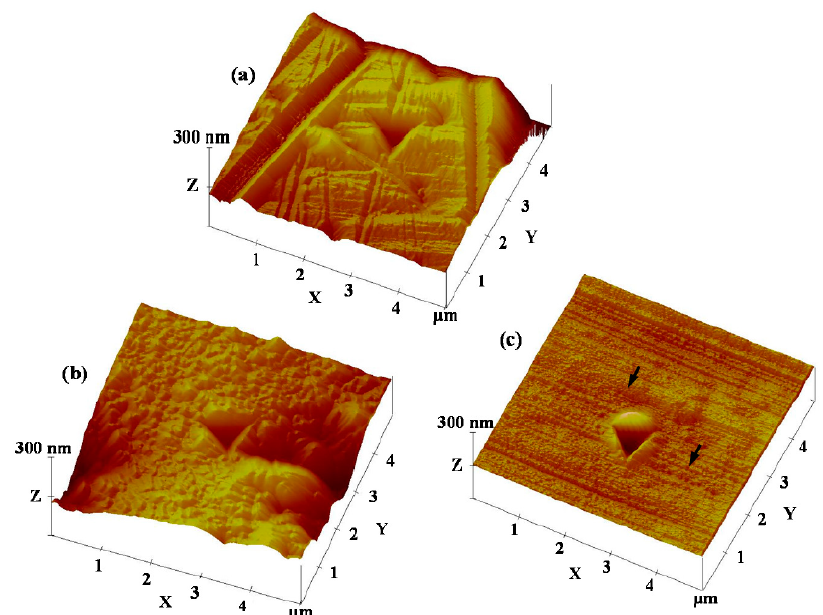
Figure 2. The topography features of the ( a ) machined, ( b ) sandblasted, large-grit, and acid-etched (SLA)-treated, and ( c ) IDCT-Ti implants coated with 1% Gly-Arg-Gly-Asp (IDCT-Ti/GRGD-1) im- plants under atomic force microscope (AFM) observation (5 µ m × 5 µ m).